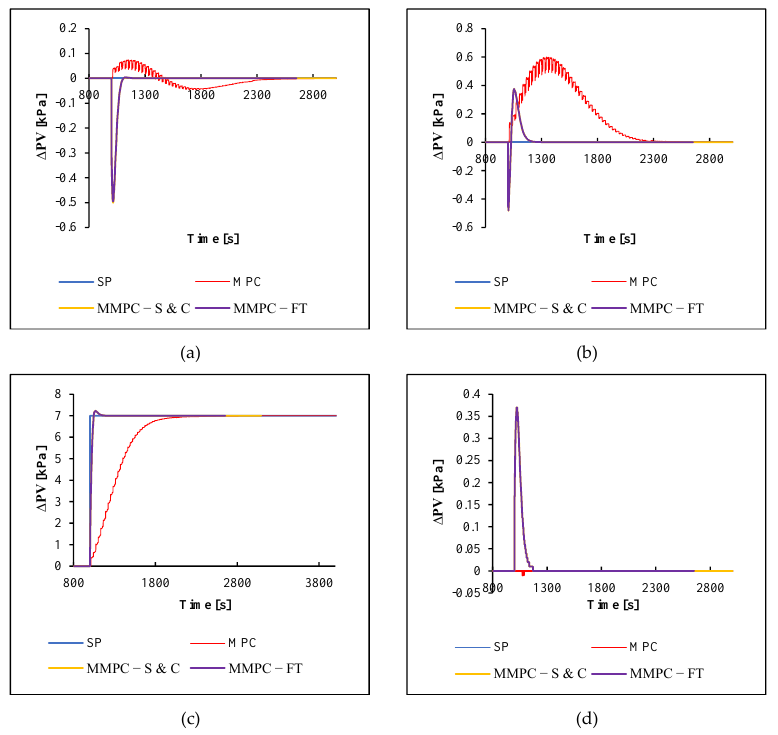
Figure 5. Comparison of controller performance with SP changes on compressor unit 3 (MIMO Model 1) on: ( a ) compressor unit 1; ( b ) compressor unit 2; ( c ) compressor unit 3; and ( d ) compressor unit 4.